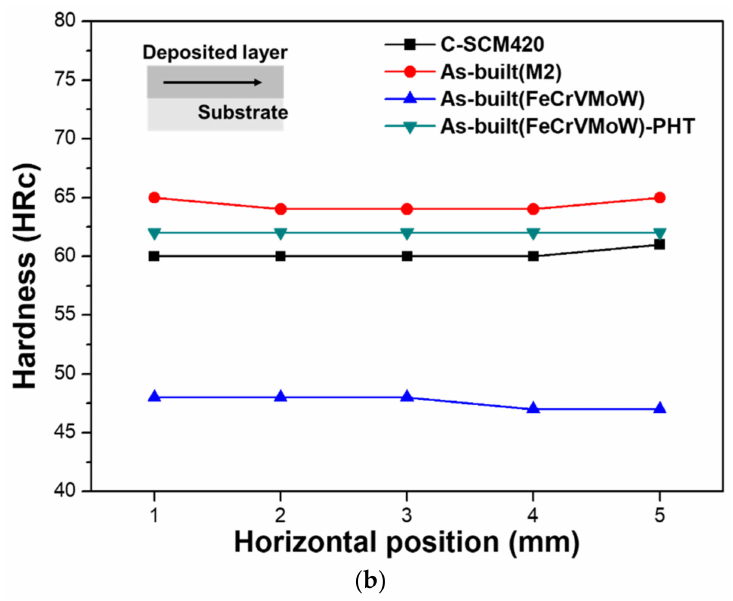
Figure 8. Hardness test profile in the ( a ) vertical direction and ( b ) horizontal direction.